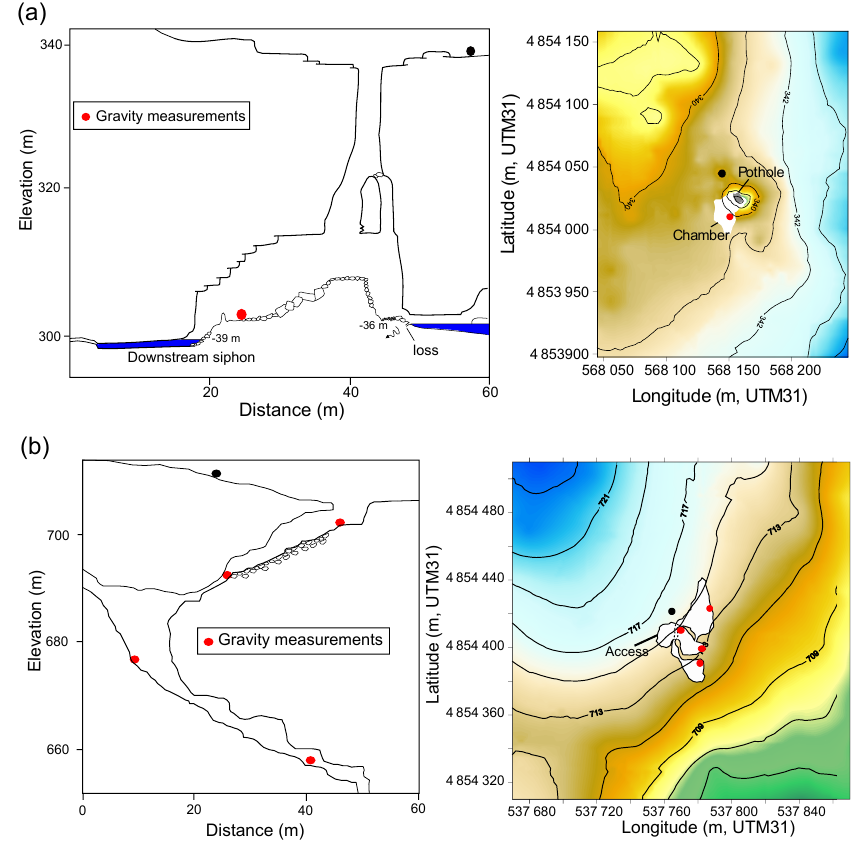
Figure 4. Developed cross section and topography surrounding (a) Seoubio caves, after Boinet (2002), and (b) Besses caves. Black and red circles indicate the location of gravity measurements. Elevations are in metres. The projections of the cave in surface are represented in grey on